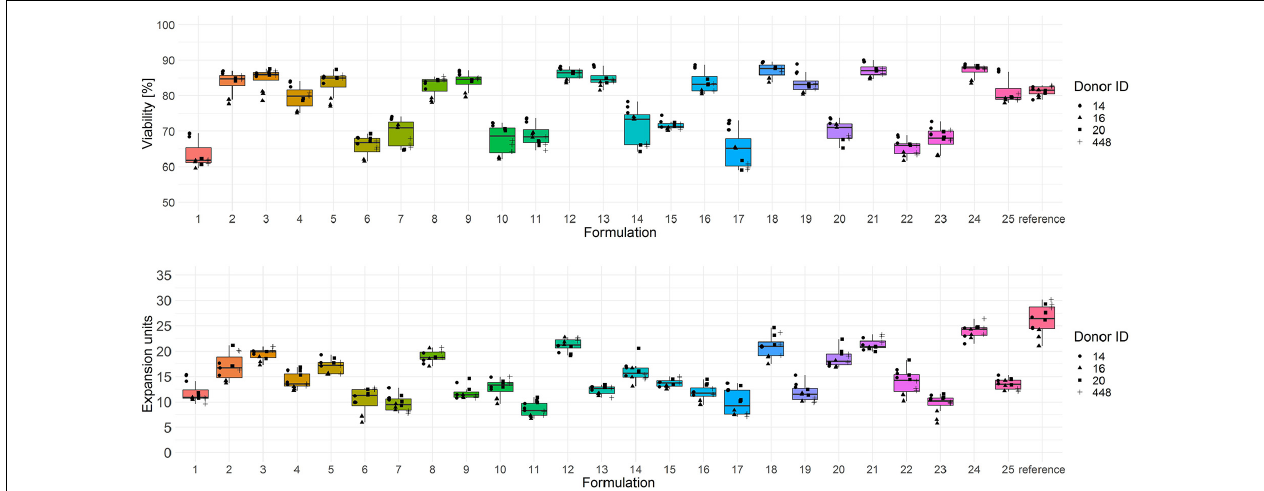
FIGURE 2 | Cryopreserved CD3 + T cells purified from human donors ( n = 4) were thawed and activated using anti-CD3/anti-CD28-coupled magnetic beads in test media or reference media in the presence of IL-7 and IL-15 (10 ng/ml, CellGenix) in three technical replicates. On day 3 cells were labeled with 7-AAD and cell viability was determined ( upper panel ). On day 6 cell counts were determined by flow cytometry and expansion was calculated ( lower panel ). Symbols indicate replicate values of individual donors.